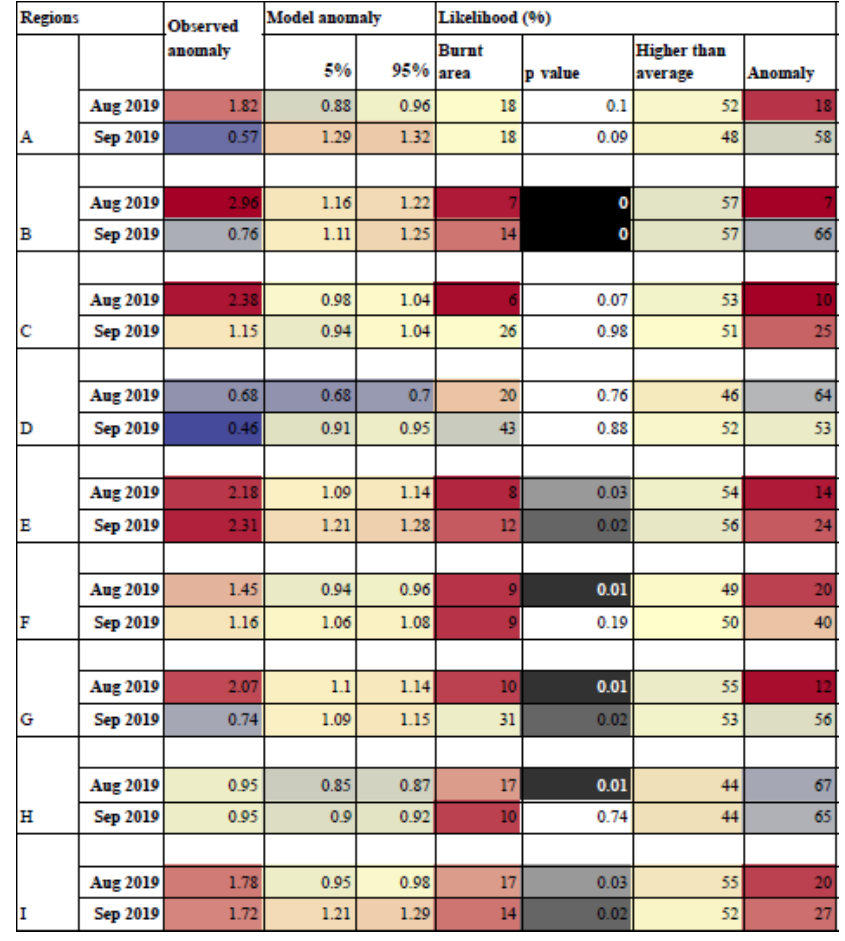
Table 1. Observed and model anomaly in burnt area for August and September 2019 as a fraction of August and September averages 2002–2019 across selected regions (see methods). Red indicates more burning than normal, blue less and yellow around average burning. The model is expressed as 5%–95% of the posterior accounting for parameter uncertainty. The first column under “likelihood” shows the percentage likelihood that the observed burnt area is as suggested by the model; the second column gives the associated p value. The third column gives the percentage likelihood that the model suggests a higher than average burnt area for the given month, and the fourth column shows the percentage likelihood that the model captures the observed anomaly based on the full model